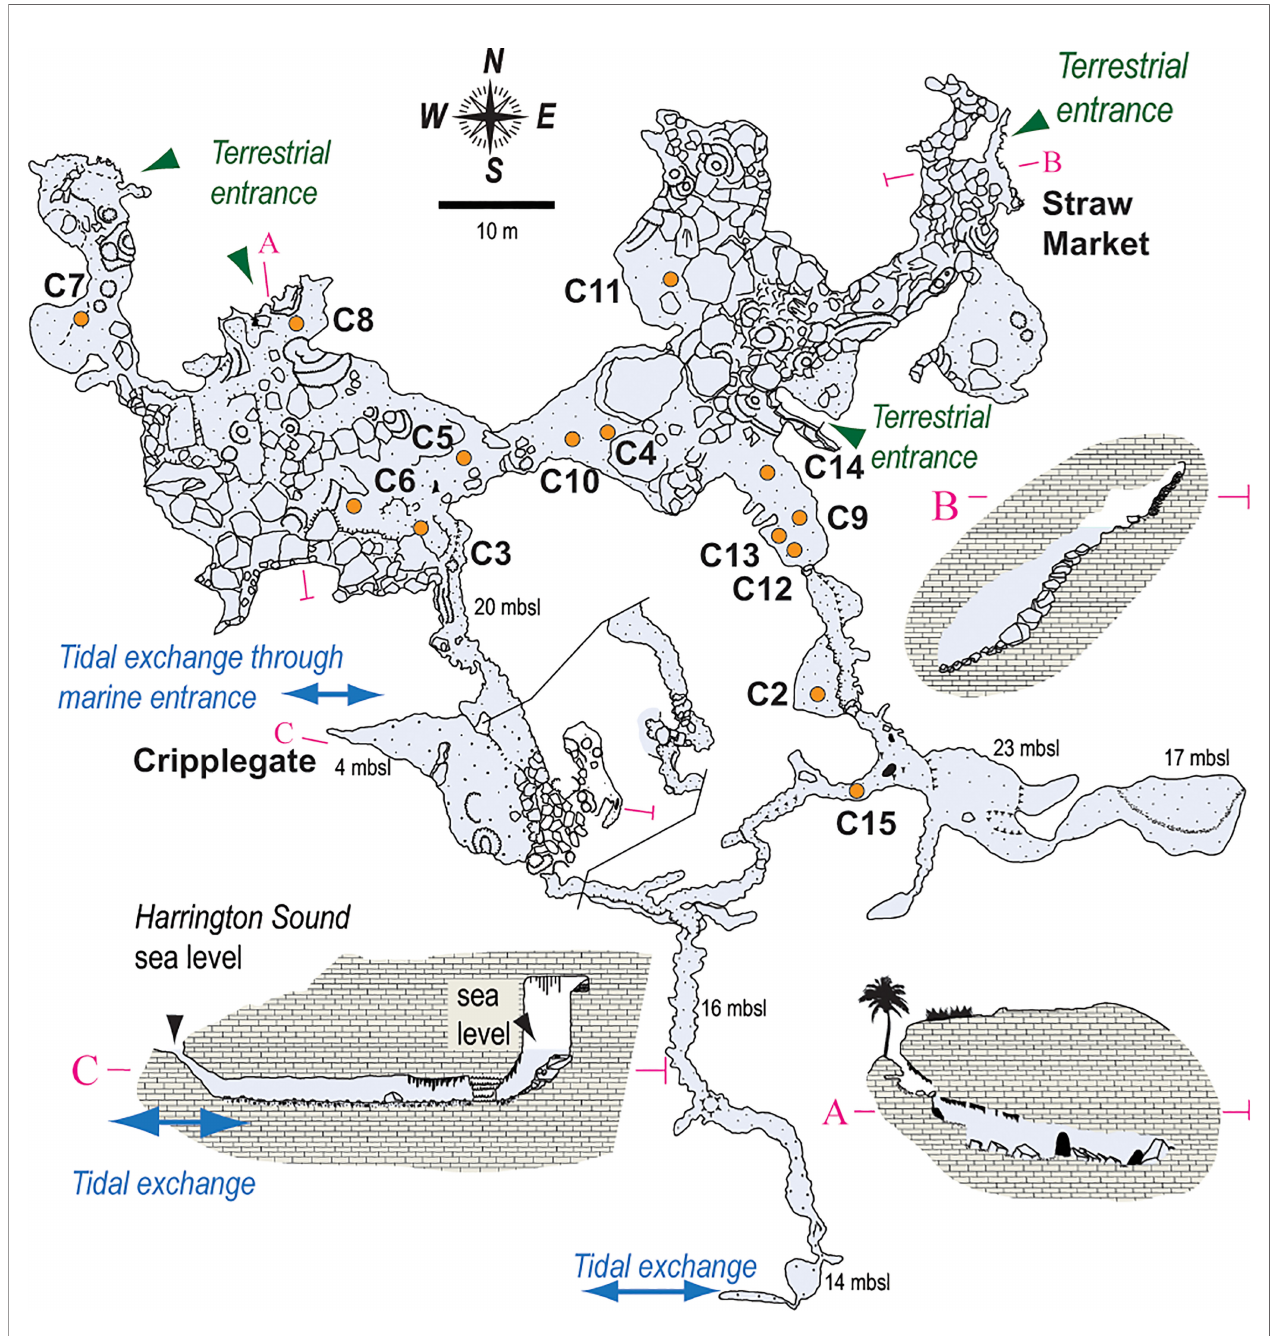
FIGURE 2 | Survey of the Palm Cave System, with core locations (orange circles) noted throughout. The narrow opening at Cripplegate (<1 m water depth) is the only known direct connection to open water. Tidal currents most elevated along eastern passages, which suggests there is perhaps also volumetrically-signi fi cant tidal-exchange of seawater between Harrington Sound and Palm Cave through the southern passages. After original cave survey drawn by Jason